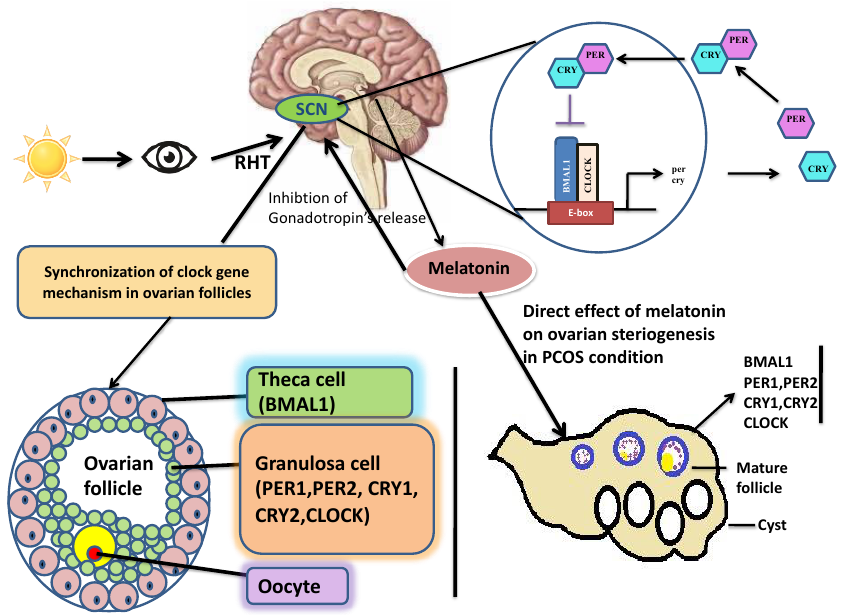
Figure 1. Possible reproductive pathways of melatonin and clock genes. Melatonin and clock genes are involved in optimal reproductive performance. Their rhythms are controlled by an endogenous molecular clock within the suprachiasmatic nucleus in the hypothalamus, which is entrained by the light/dark cycle. Both melatonin and clock genes exist in ovarian granulosa cells. Disruption of melatonin and clock genes rhythms interferes with ovarian steroidogenesis and reproductive function. SCN = suprachiasmatic nucleus, RHT = retinal-hypothalamic tract.